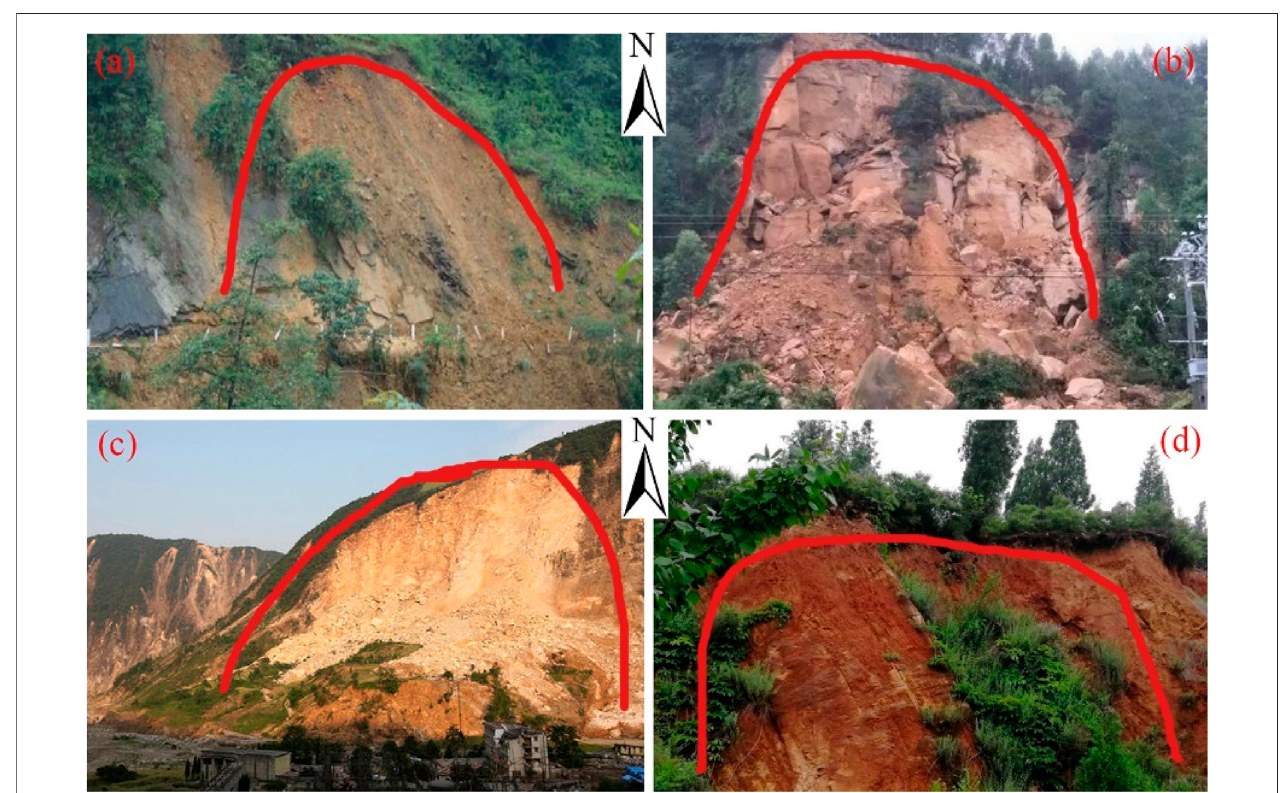
FIGURE 3 | Photos of typical collapses in Ganzhou City. (A – D) Examples of four collapses in Ganzhou.